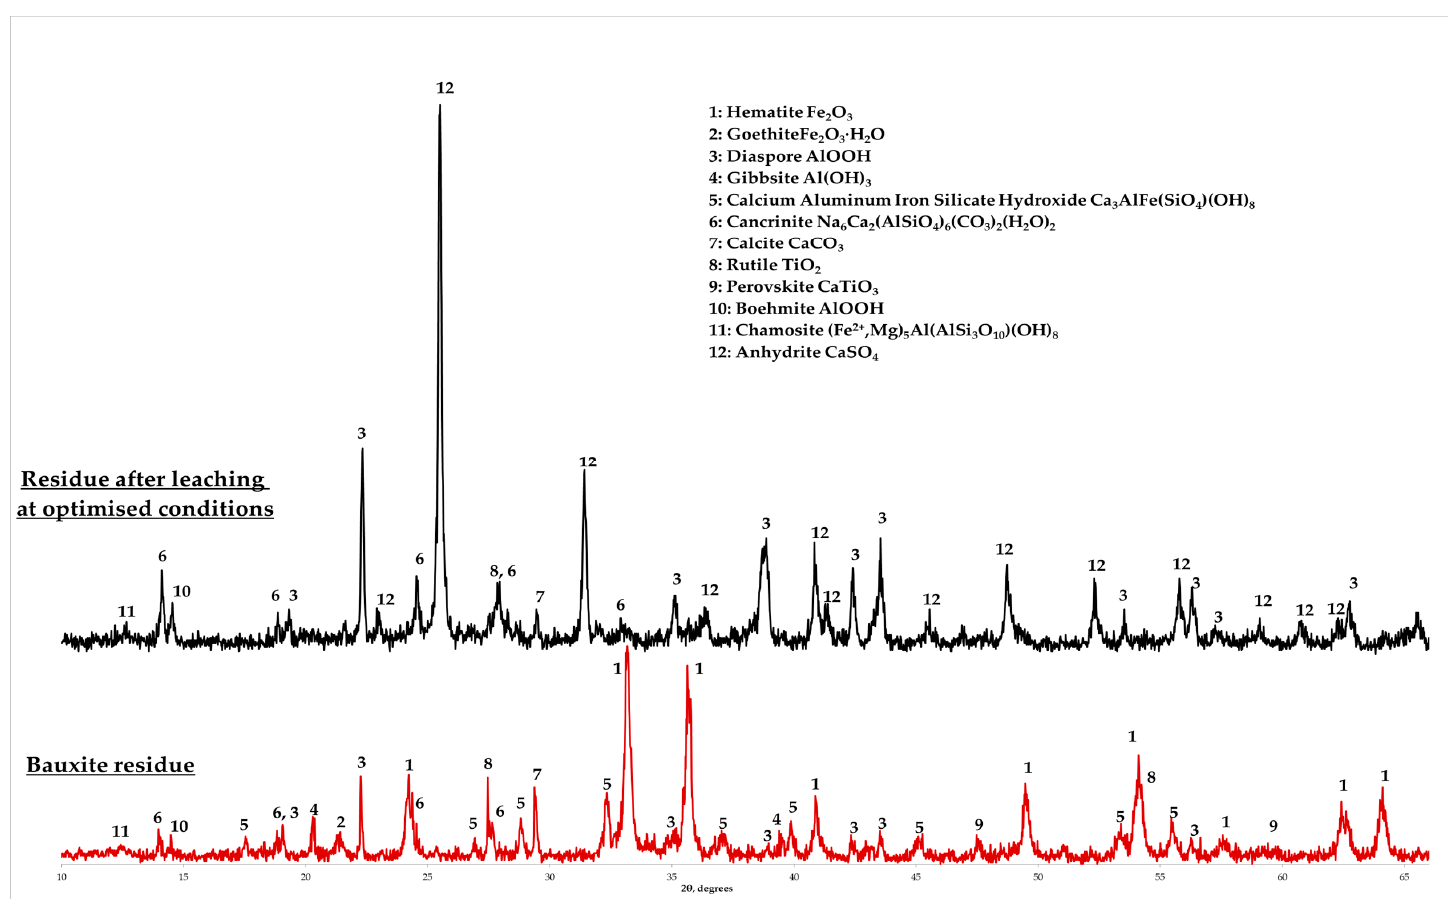
Figure A4. Comparison of the XRD spectra of bauxite residue and solid residue after leaching at optimum conditions.